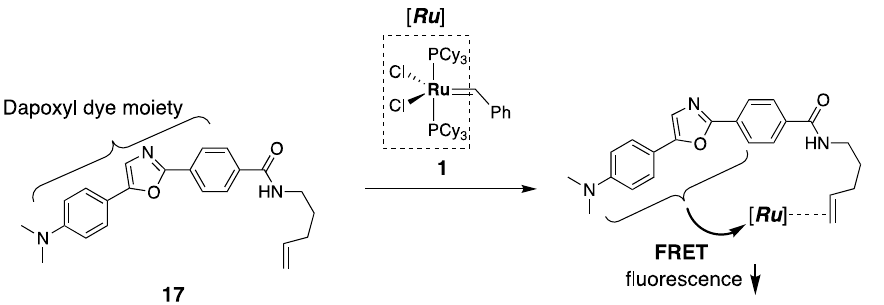
Figure 9. Detection of a dye–olefin conjugate by ruthenium–olefin interaction on Grubbs first- generation catalyst [43]. generation catalyst